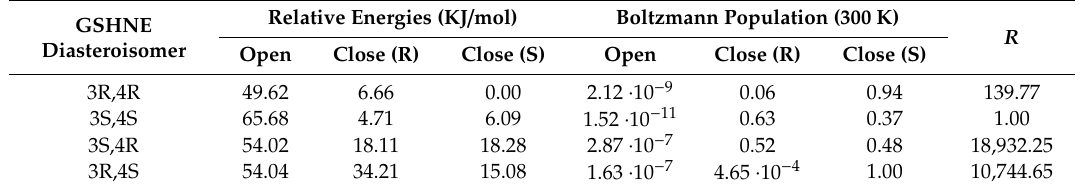
Figure 3. Time-course disappearance of the substrate and appearance of the product during GSHNE transformation catalyzed by h AKR1B1. Time-course of GSHNE disappearance (circles) and GSDHN formation (triangles) as obtained by plotting the different sampling times for the peak areas of the molecular species at m / z values of 464.25 and 466.22, respectively. Peak areas are the mean values ± SD over five chromatographic runs for each sampling time; error bars, when not visible, are within the symbol’s size. Table 2. Relative energies and Boltzmann populations of GSHNE diastereoisomers.